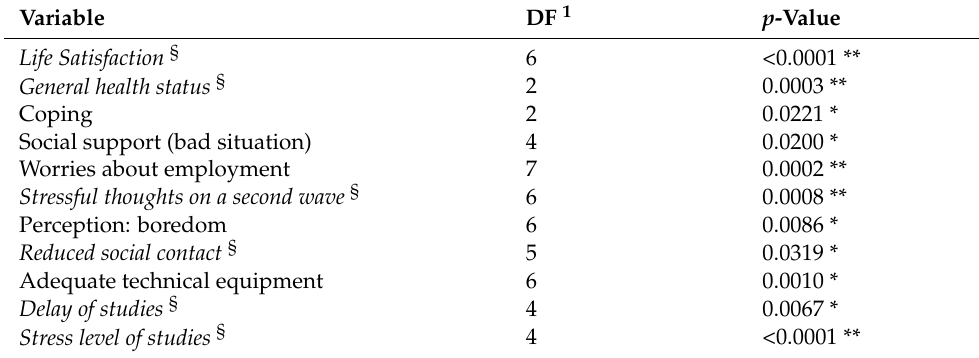
Table 3. Alternative outcome